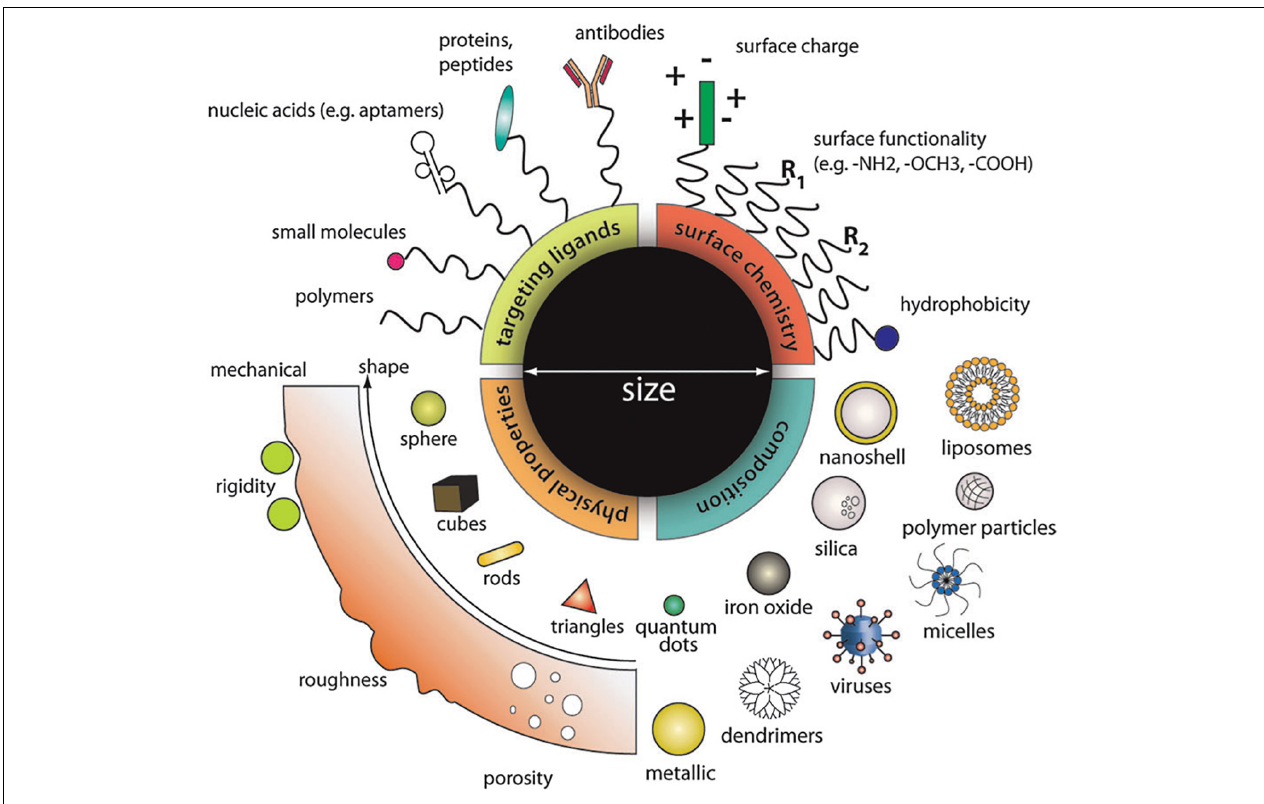
FIGURE 3 | Material composition, surface properties, and functional groups can all be tuned to modulate the functional properties of nanoparticles such as drug loading and release kinetics, fluorescence, cell targeting, diffusion, cellular uptake, and many more. The modular nature of nanoparticles makes them ideal for optimizing the delivery of molecules for specific bioapplications. Reprinted with permission from Ref 55. Copyright 2011 Royal Society of